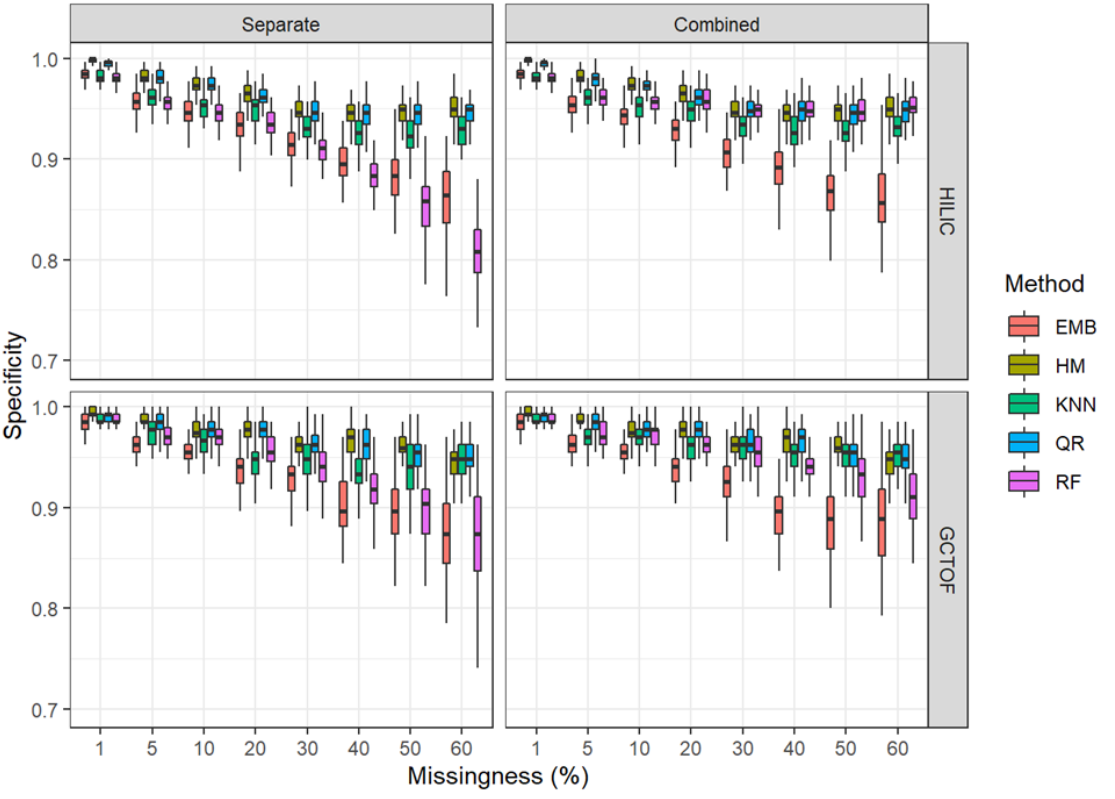
Figure 5. Box and whisker plots of specificity HILIC and GCTOF data